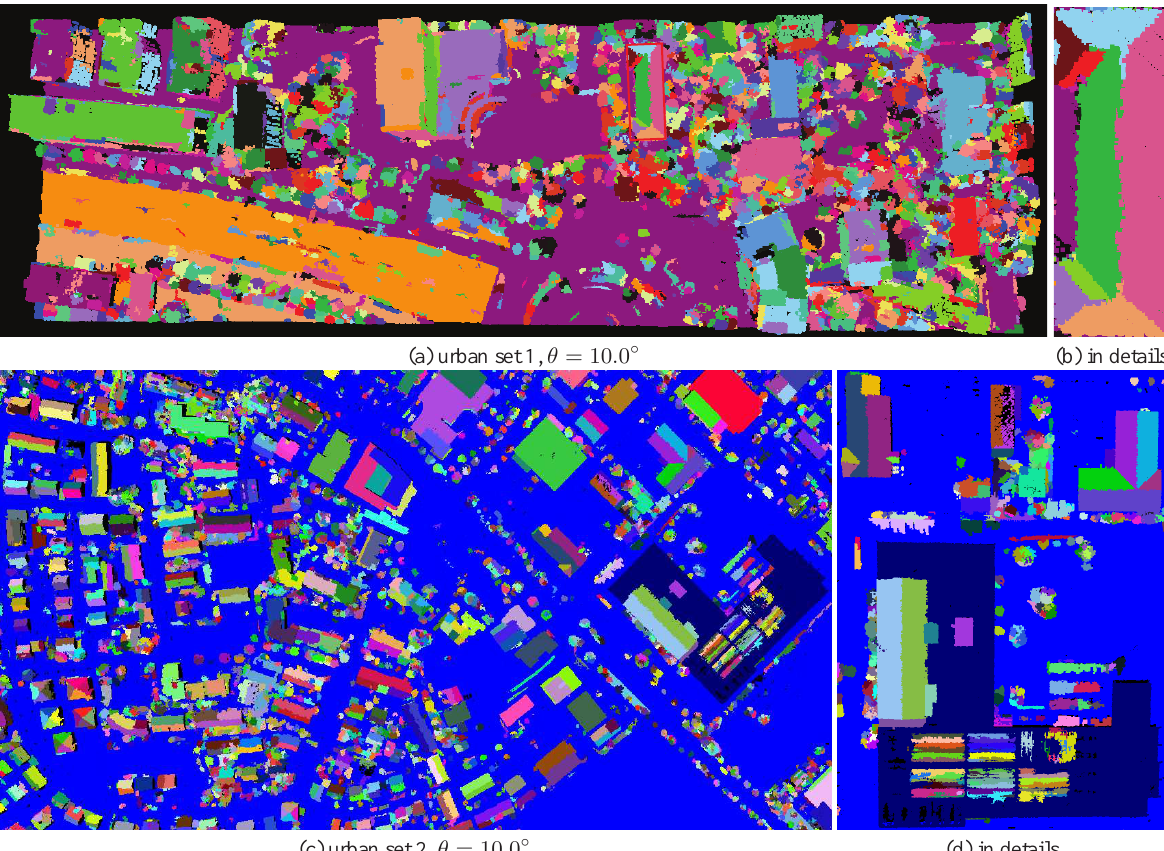
Figure 7: Segmentation results of the proposed method on two aerial data